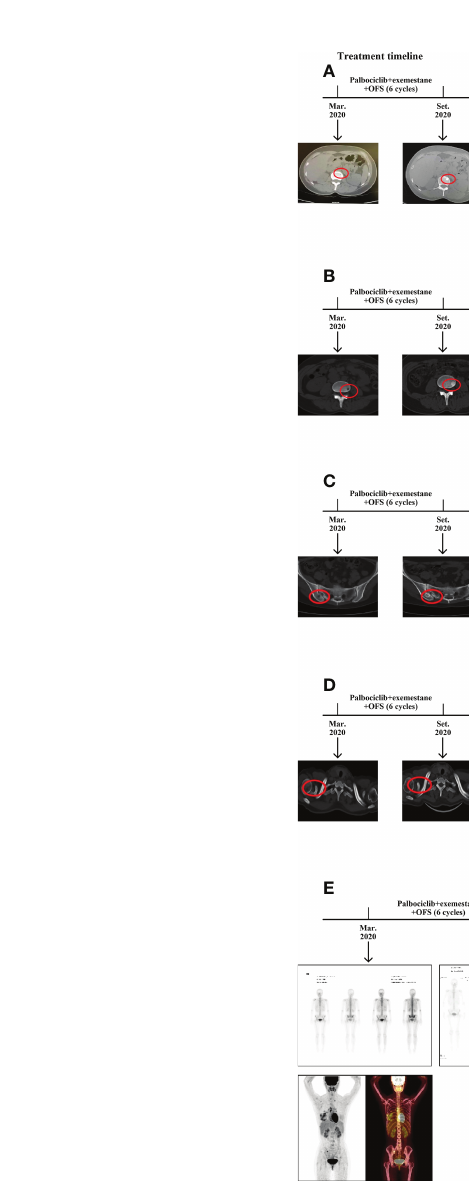
FIGURE 4 Changes in bone lesions during the treatment. (A) CT evaluation of the lumbar lesion 1 during the treatment. (B) CT evaluation of lumbar the lesion 2 during the treatment. (C) CT evalution of the right sacroiliac joint during the treatment. (D) CT evaluation of the coracoid process of the right scapula during the treatment. (E) SPECT/CT evaluation during the treatment. T: Albumin paclitaxel; X: Albumin